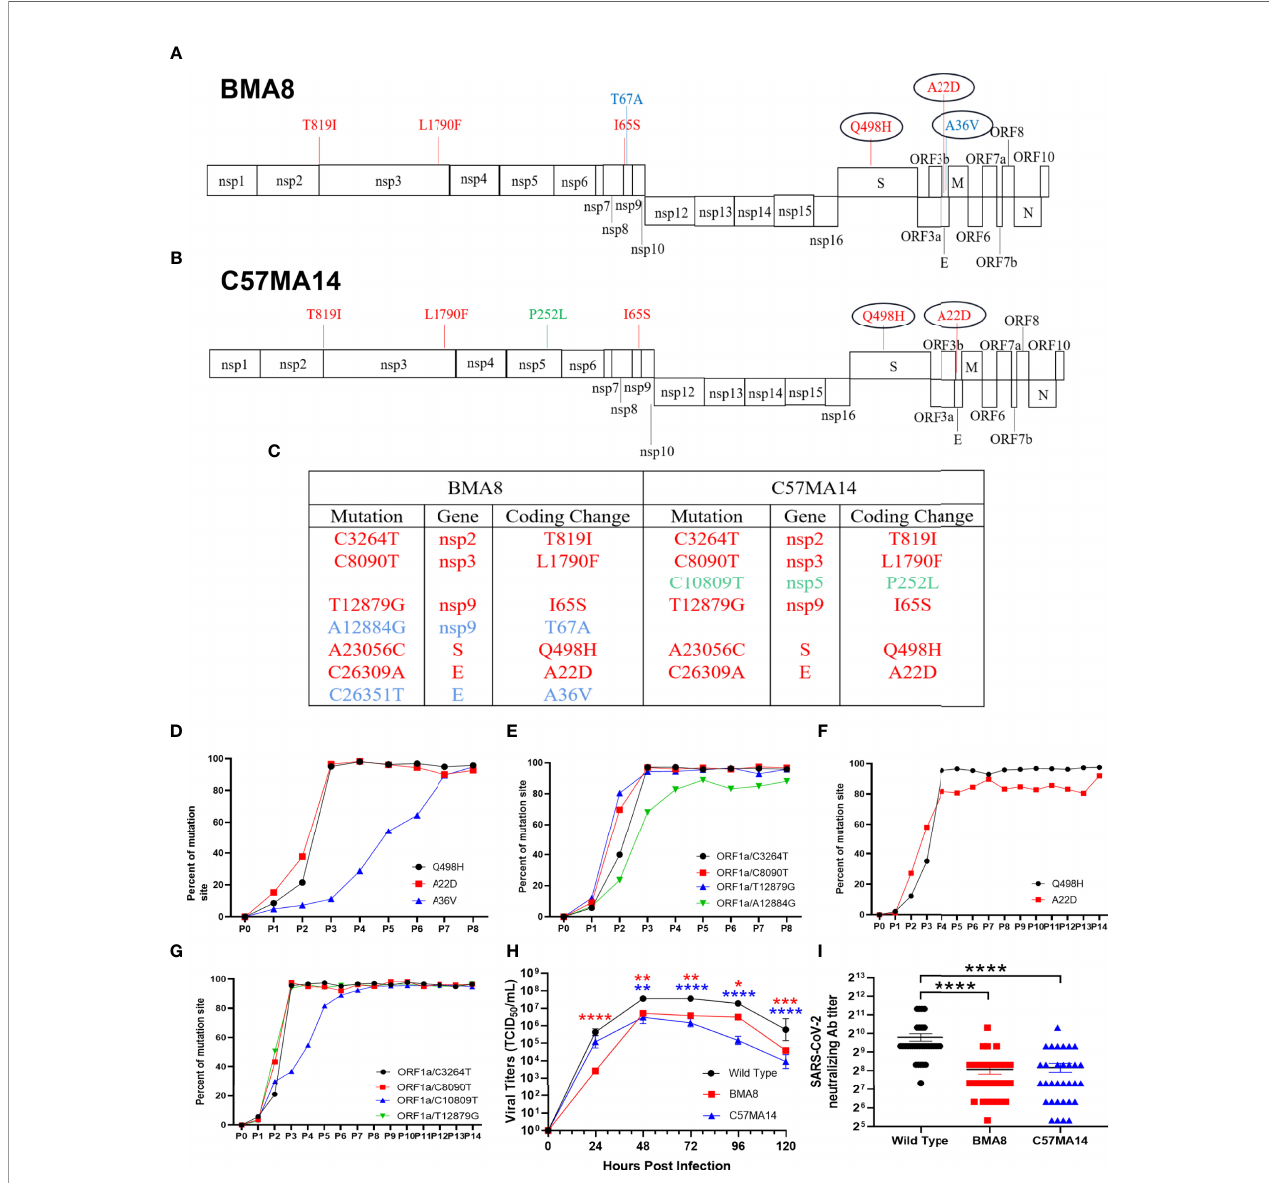
FIGURE 1 | Two mouse-adapted strains of severe acute respiratory syndrome 2 (SARS-CoV-2) from outbred mice carry unique amino acid substitution. Schematic diagram of SARS-CoV-2 genome and all the adaptive mutations of amino acid identi fi ed in BMA8 (A) and C57MA14 (B) compared with the SARS-CoV-2 Wuhan01. “ nsp ” , nonstructural protein; “ S ” , Spike Protein; “ ORF ” , Open Reading Frame; “ E ” , Envelope Protein; “ M ” , Membrane Protein; “ N ” , Nucleocapsid Protein. (C) Table of mutations present in plaque puri fi ed mouse-adapted SARS-CoV-2 BMA8 and C57MA14. Red font showed the same mutations in both mouse-adapted variants. Blue font showed the mutations only occurring in SARS-CoV-2 BMA8. Green font showed the mutation only occurring in SARS-CoV-2 C57MA14. The proportions of all the amino acid mutations in both mouse-adapted strains were calculated in each passage (D – G) . One-step growth curves of SARS-CoV-2 Wuhan01, BMA8, and C57MA14 were measured in Vero E6 cells. n = 3 technical replicates for each group, representative of 2 independent experiments (H) . Neutralization capabilities of the serum samples from 32 SARS-CoV-2-infected individuals were measured with BMA8, C57MA14, and SARS-CoV-2 Wuhan01 (I) . (*P < 0.05, **P < 0.01, ***P < 0.001, ****P <